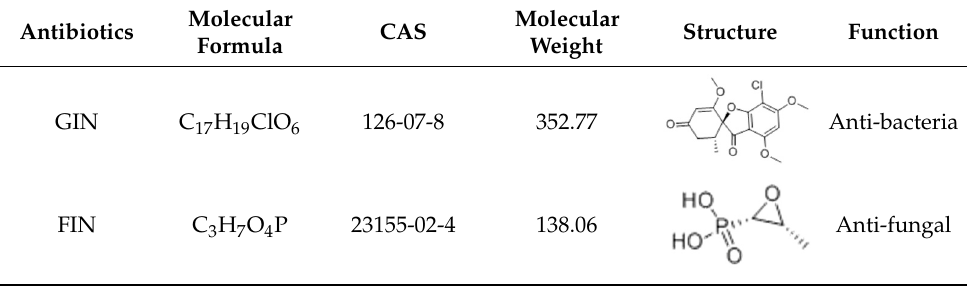
Table 1. Antibiotics used in this study.